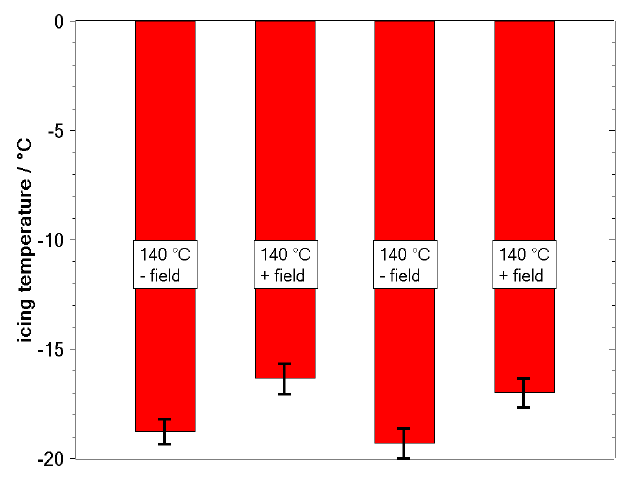
Figure 7. Reversibly-tunable freezing temperature on P(VDF-TrFE)-coated glass after several thermal treatment cycles at 140 °C with an alternating direction of the electric field starting with a negative field orientation subsequent to a no-field-treatment.